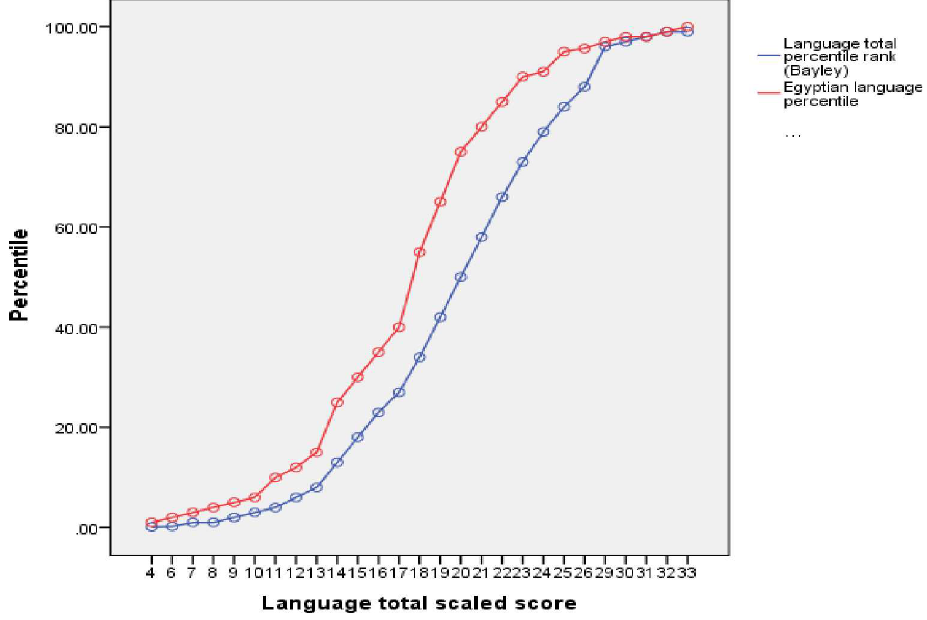
Fig 2. Egyptian versus American percentiles of language